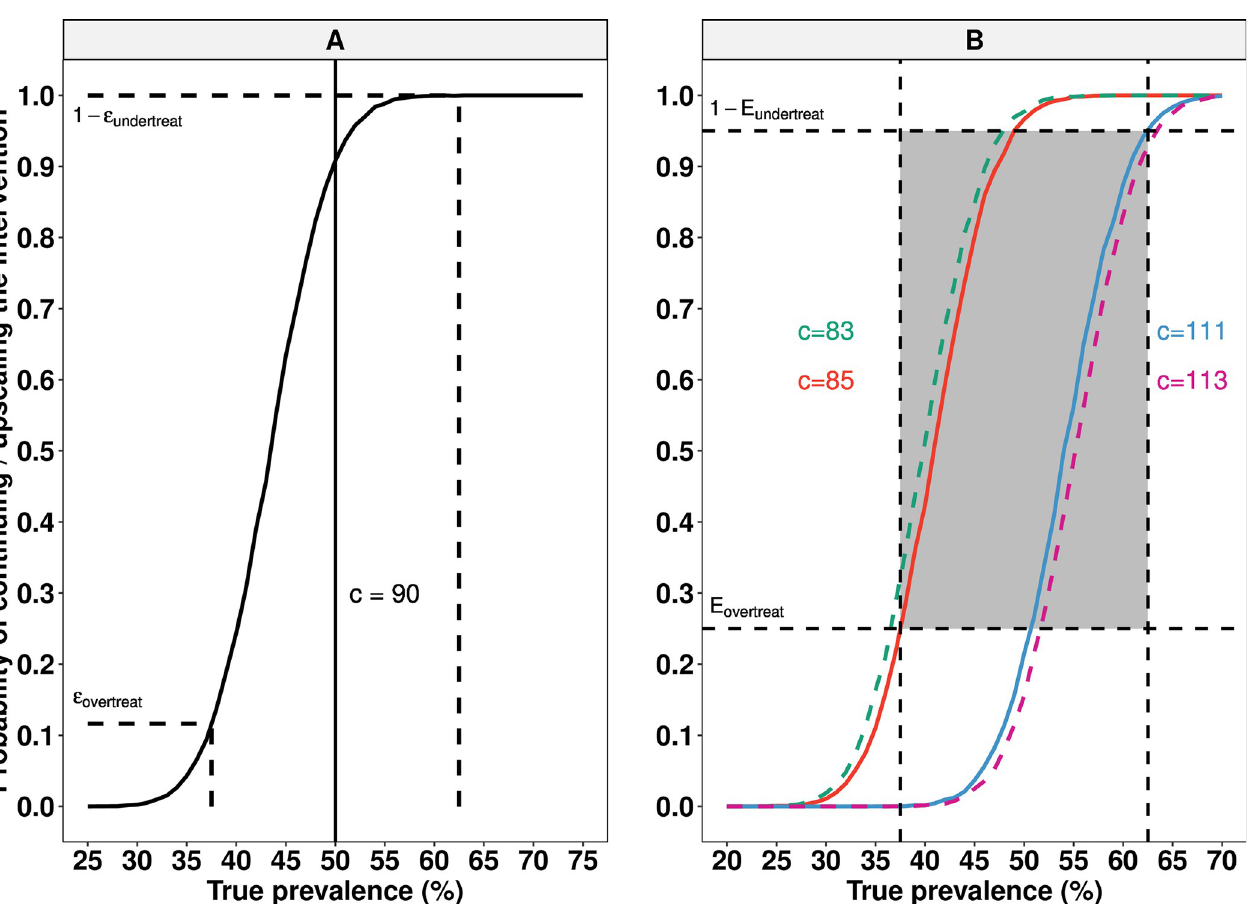
Fig 2. Program decision-making process based on 2-stage LQAS framework allowing for an imperfect diagnostic test. Panel A illustrates the risk of making a wrong program decision ( ε and ε ) for a given true prevalence π and decision cut-off c = 90 was applied. The vertical straight line overtreat undertreat i indicates the program prevalence threshold T = 50% , whereas the horizontal dotted lines represent the ε overtreat and ε undertreat for π i = 37.5 % and π i = 62.5 %, respectively. Panel B represents the decision cut-off c for a choice of grey zone width (lower limit ( LL ) = 37.5% and upper limit ( UL ) = 62.5%) and acceptable risk levels ( E overtreat = 25 % and ε undertreat = 5 %) for a particular of range of π i . The solid sigmoid curves (in red and blue) indicate the values of c that satisfy the ð π ¼ LL Þ � E and ε ð π ¼ UL Þ � E , whereas the dotted sigmoid curves (green and purple) do not satisfy the conditions ε overtreat i overtreat undertreat i undertreat conditions mentioned above. All graphs are based on the same theoretical diagnostic test D ( se = 80 % and sp = 98 %), survey design ( n = 5 and n = 50 ), d d clust sub an intra-cluster correlation ρ i = 0.02 and 10,000 Monte Carlo